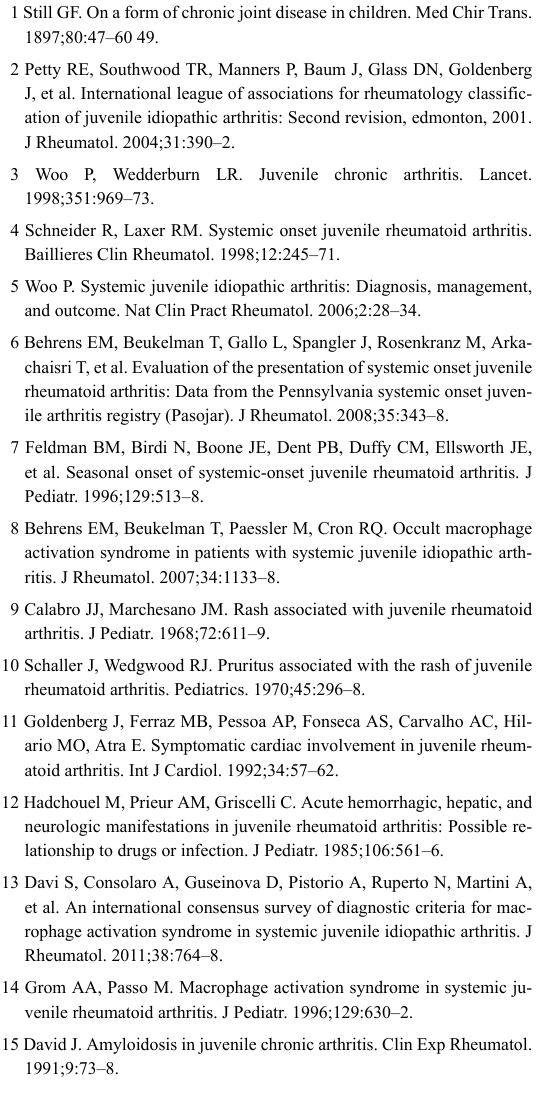
Table 3: Main treatments used for Systemic-onset JIA. Treatment Standard dose